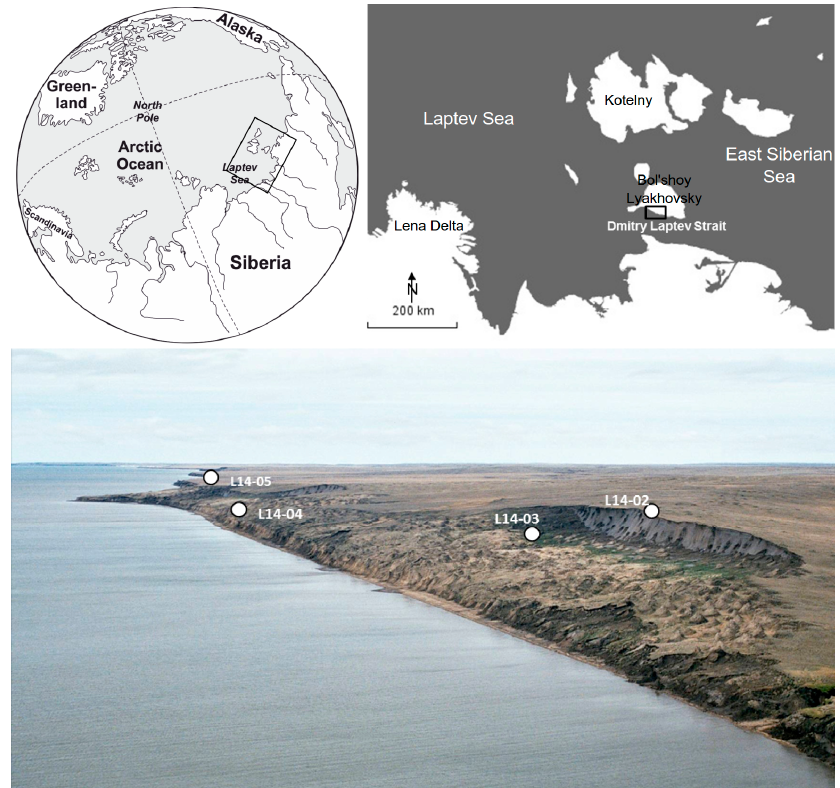
Figure 1. Map showing the location of Bol’shoy Lyakhovsky Island in the upper panel and an overview of the core drilling sites in an aerial photograph of the southern coast of the island (modified after [48]).